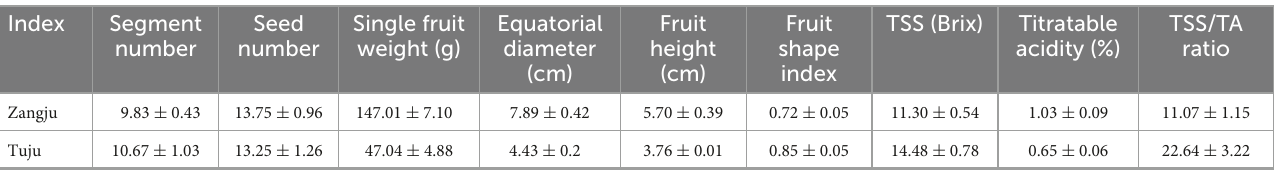
TABLE 1 Fruit characteristics and quality of Zangju and